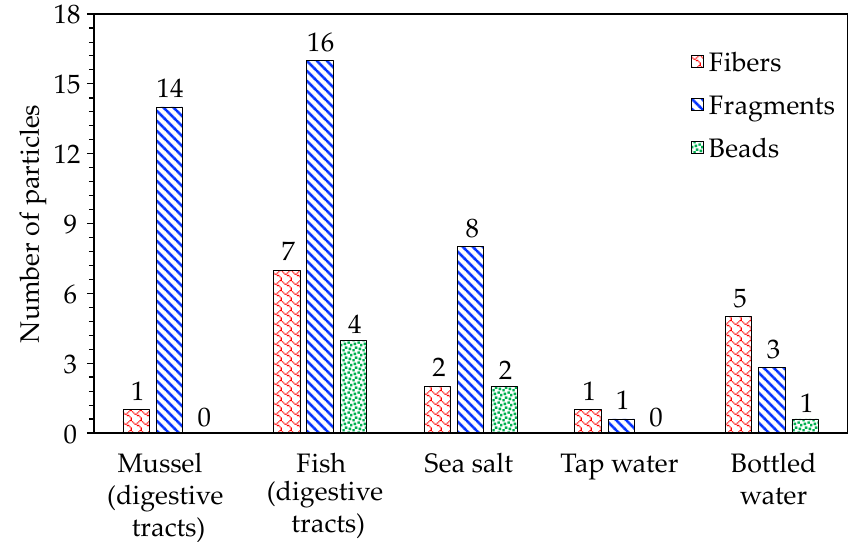
Figure 6. The number of particles found in each sample. Data attained express the normalized number of particles found per 100 g of NZ green-lipped mussel, tarakihi fish and sea salt samples. The normalized number of particles in tap water and bottled water samples are expressed per liter of sample.